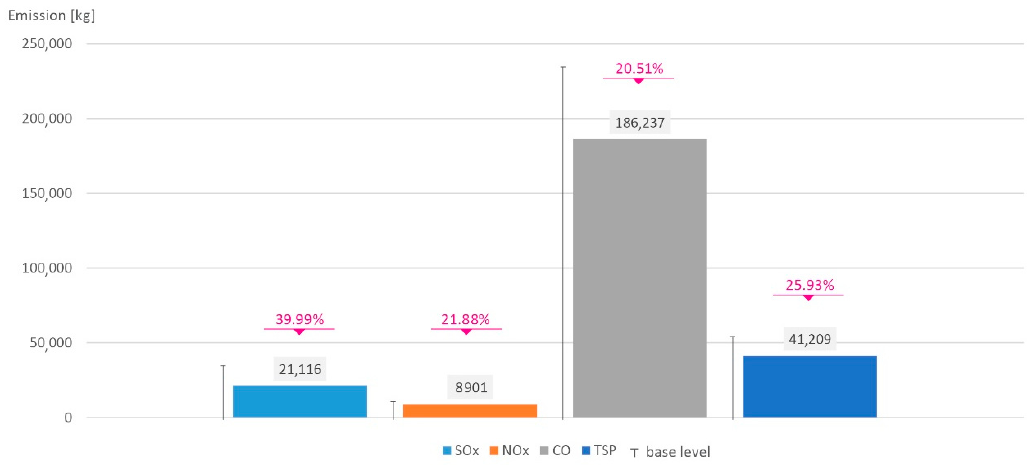
Figure 11. Annual emissions of pollutants in Model 5: 40% coal, 40% biomass, 5% fuel oil, 15% heat pumps.